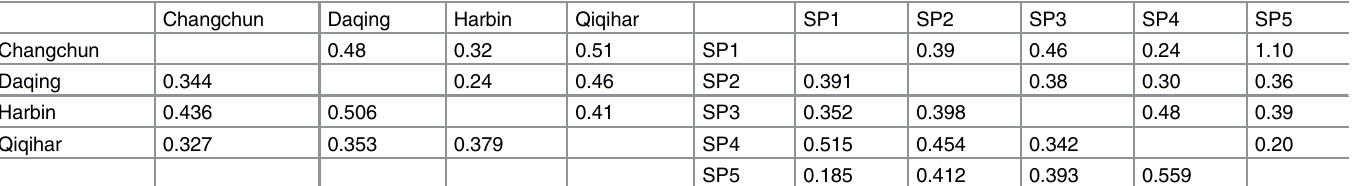
Table 6. Pairwise genetic distance ( F ST , lower diagonal, P < 0.001) and gene flow ( Nm , upper diagonal) between Enterocytozoon bieneusi